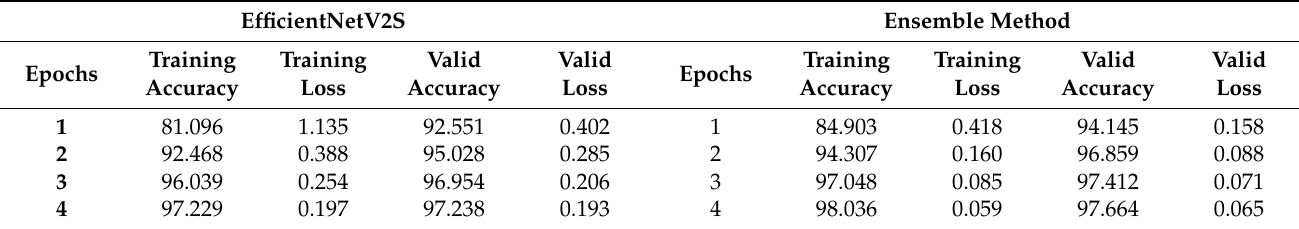
Table 2. Testing score of the EfficientNetV2S model and the ensemble model.